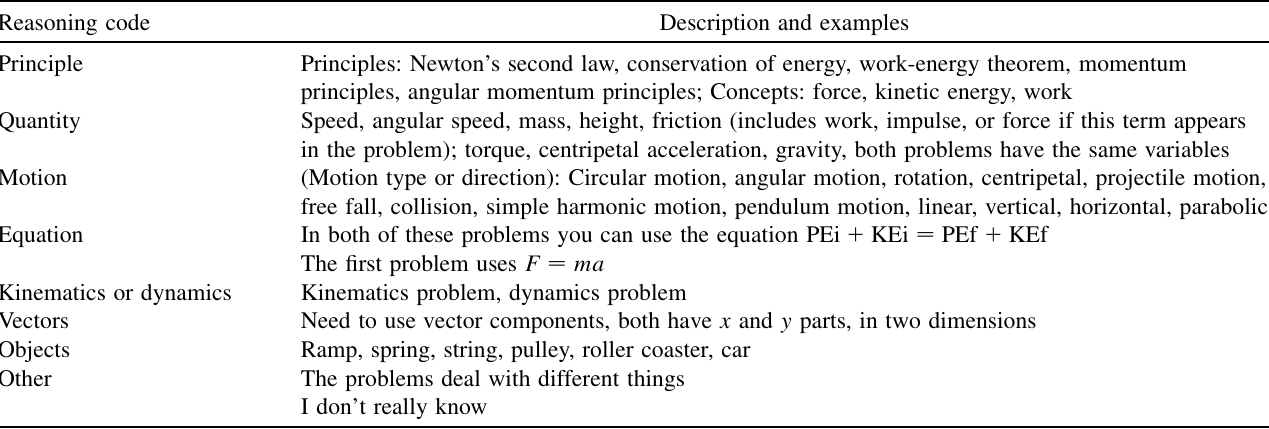
TABLE I. Classification scheme for participants’ typed reasoning